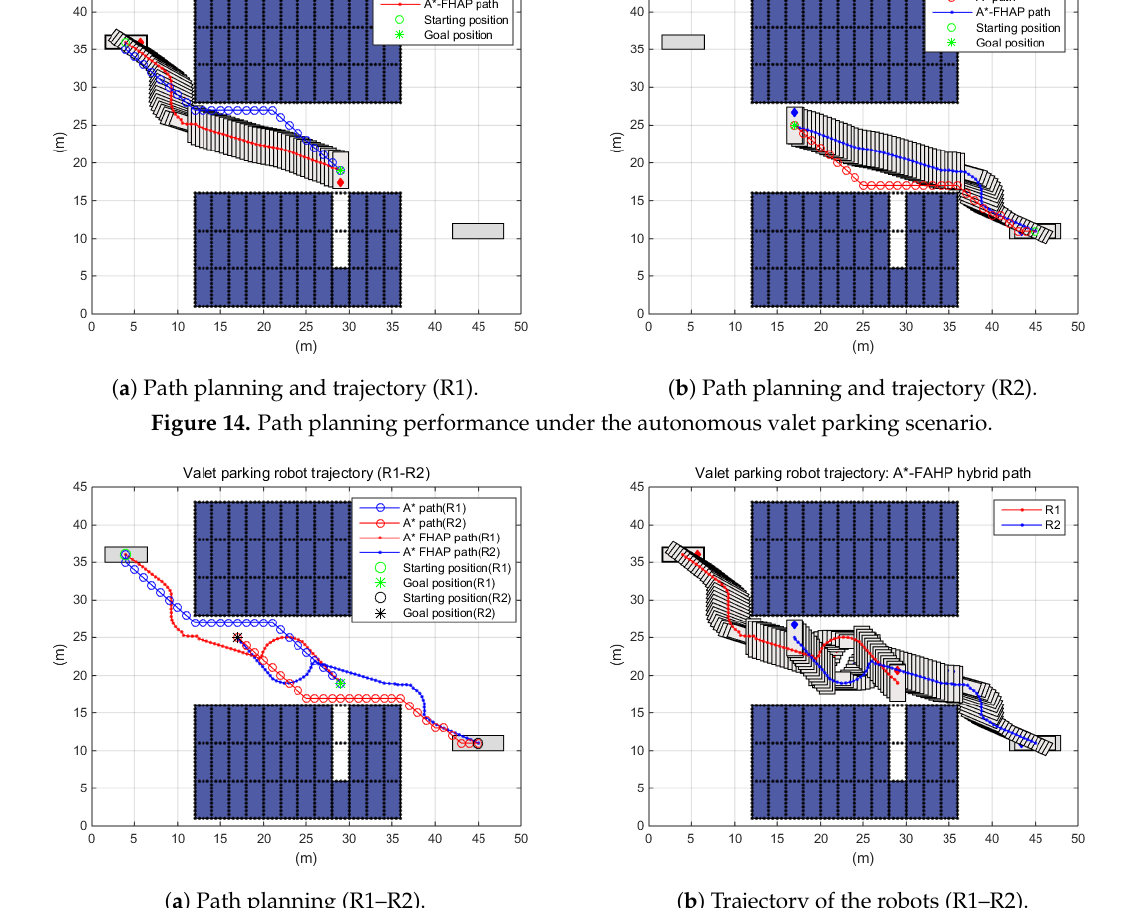
Figure 15. Multi-robot path planning performance under autonomous valet parking